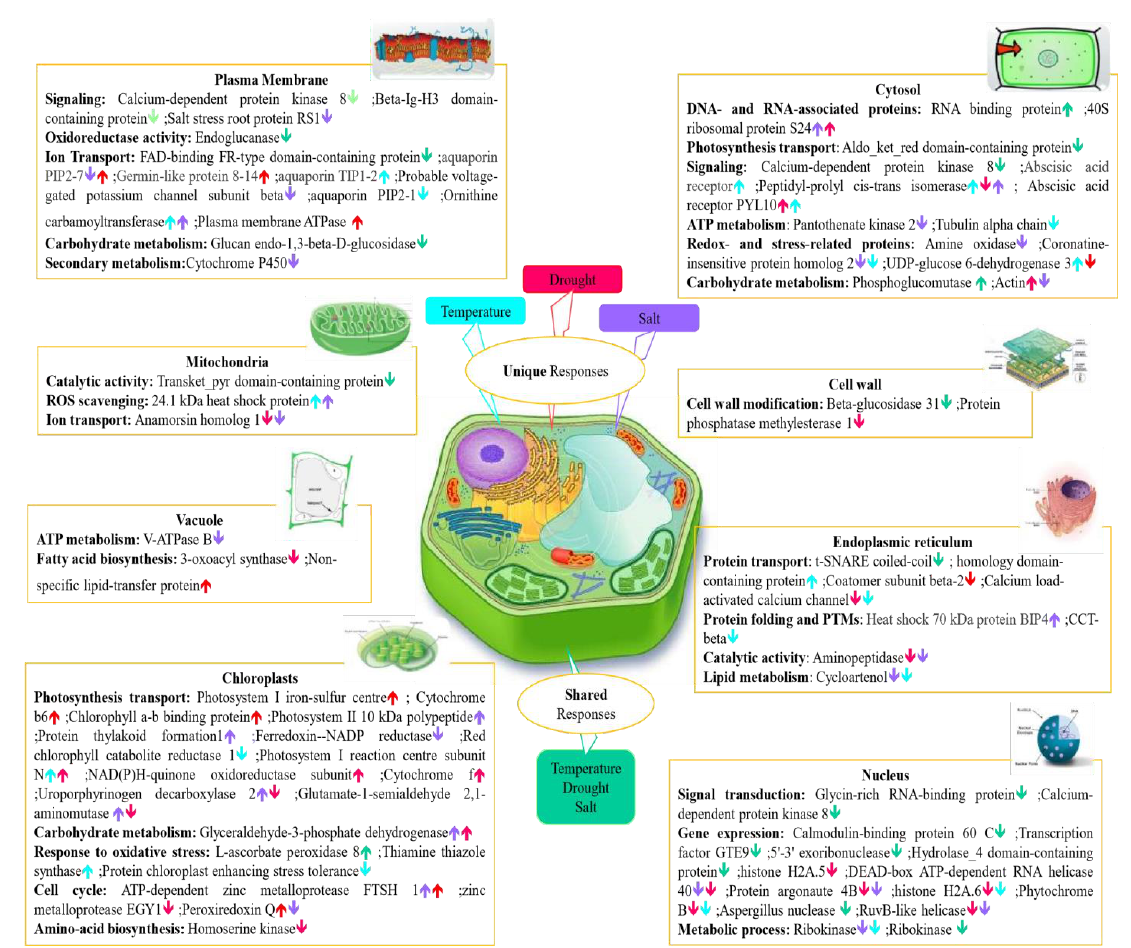
Figure 5. A schematic summary of the major stress-responsive proteins identified in this study, presented in context of their individual plant cell compartments. Differentially abundant proteins under drought, salt, and temperature stress are highlighted with distinct colours including salt unique proteins (purple), temperature unique proteins (blue), drought unique proteins (red), and shared proteins among all abiotic stresses (green). Upward and downward arrows indicate proteins increased and decreased in abundance.